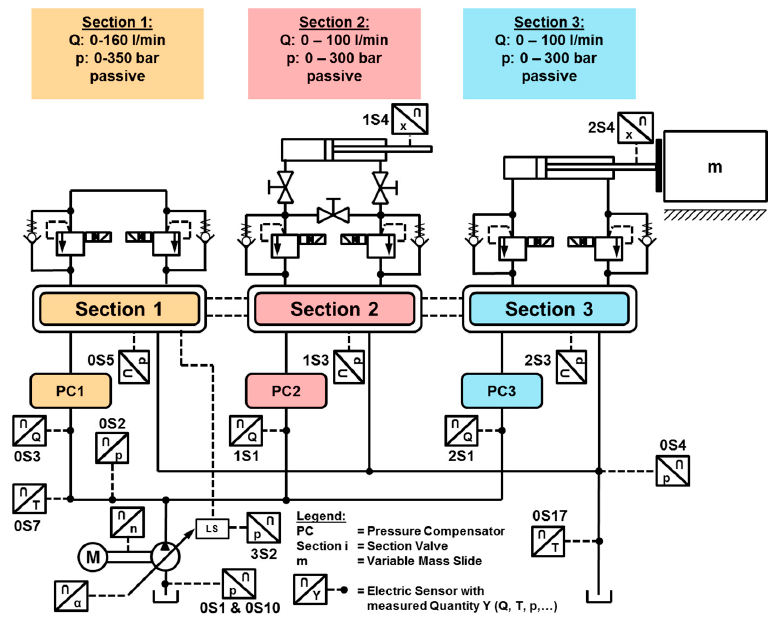
Figure 13. LS system test rig. Previously reported in [15]. Reproduced with permission from the publisher.